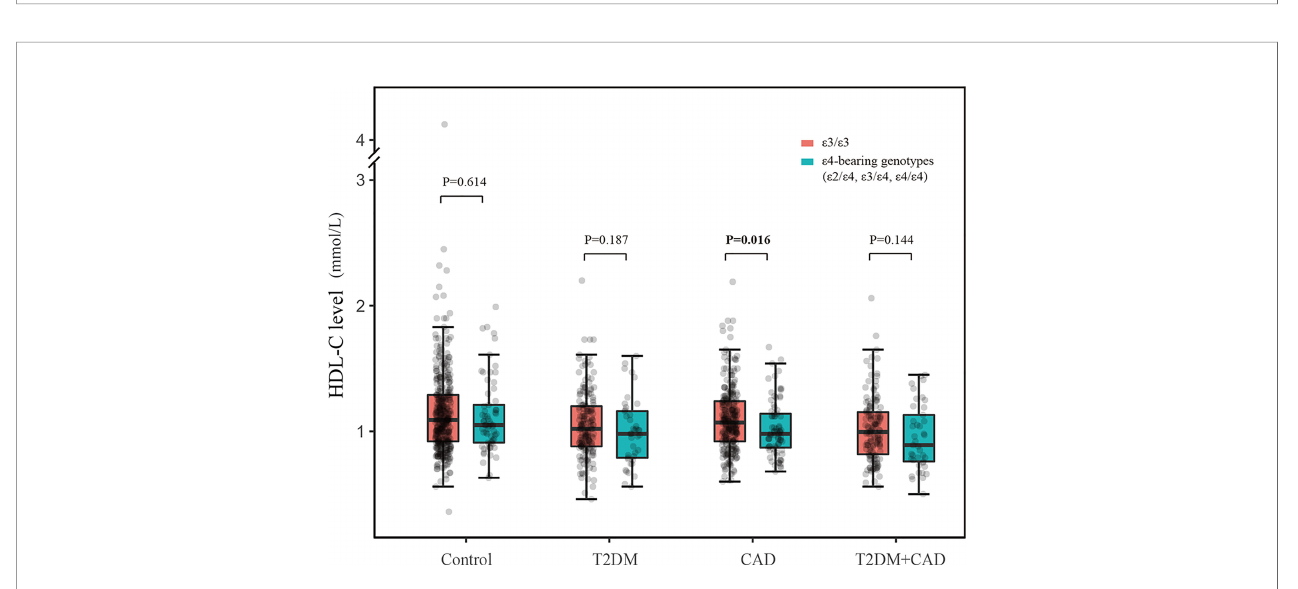
FIGURE 3 | Correlation between plasma HDL-C level values and APOE ϵ 4-bearing genotypes ( ϵ 2/ ϵ 4, ϵ 3/ ϵ 4, and ϵ 4/ ϵ 4).